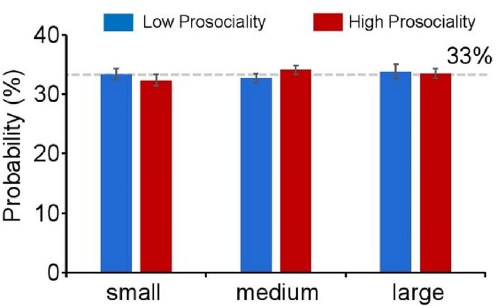
Figure 2. Behavioral results. The probabilities of each card choice are shown. Red is the high prosocial group and blue is the low prosocial group. Small: the individual choose a card containing 0 star. Medium: the individual choose a card containing 1 star. large: the individual choose a card containing 1 star.